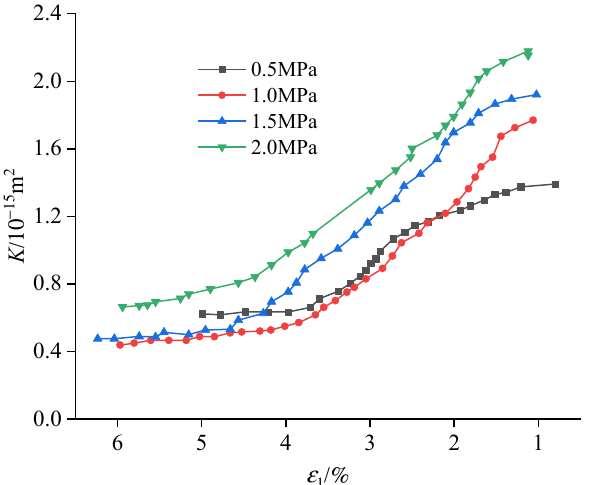
Figure 10. Curves of seepage characteristics of axially unloaded coal samples under a constant CP of 4 MPa and different GPs.